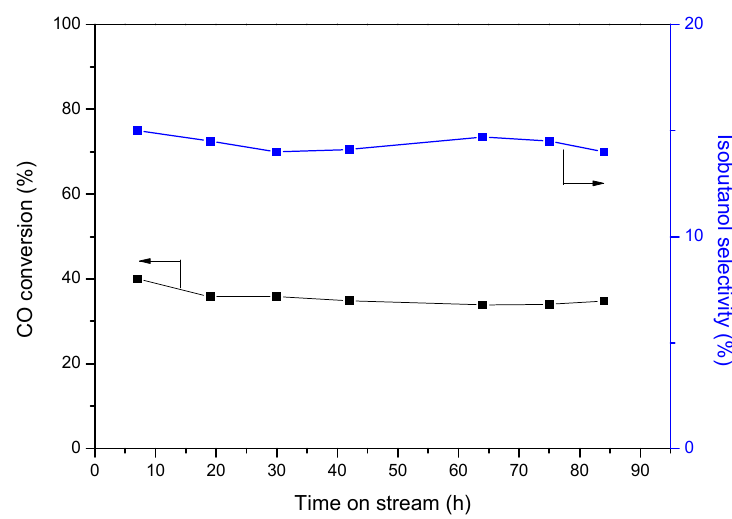
Figure 1. The stability of A-KCZ catalyst under reaction conditions (300 °C, 10 MPa, 3000 h − 1 ).